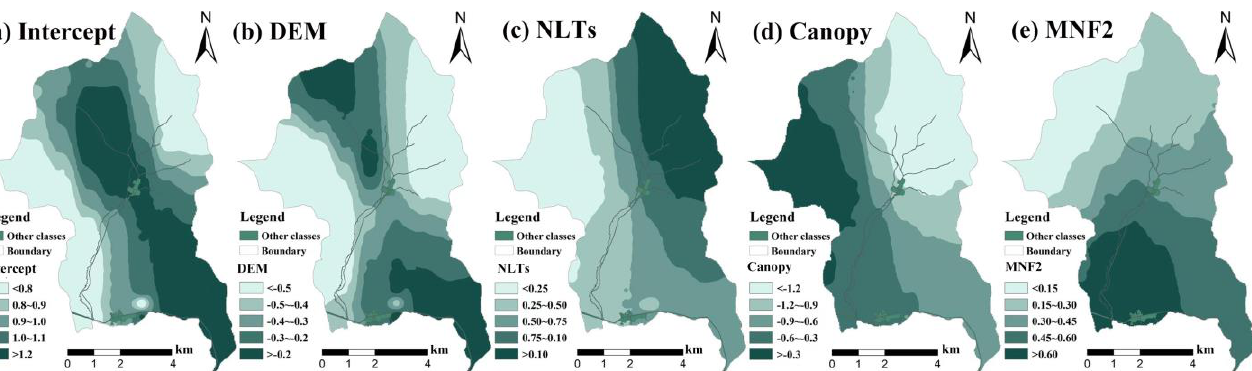
Figure 6. Visual and hotspot analysis of the NRT prediction results obtained from the four models and the ground-observed values. ( a ) PR represents the Poisson regression, ( b ) LMPR represents the Liner mixed PR, ( c ) GWPR represents the Geographically weighted PR, ( d ) SGWPR represents the semiparametric GWPR, and ( e ) Ground-observed data. Note: NRTs represents the number of recruitment trees.